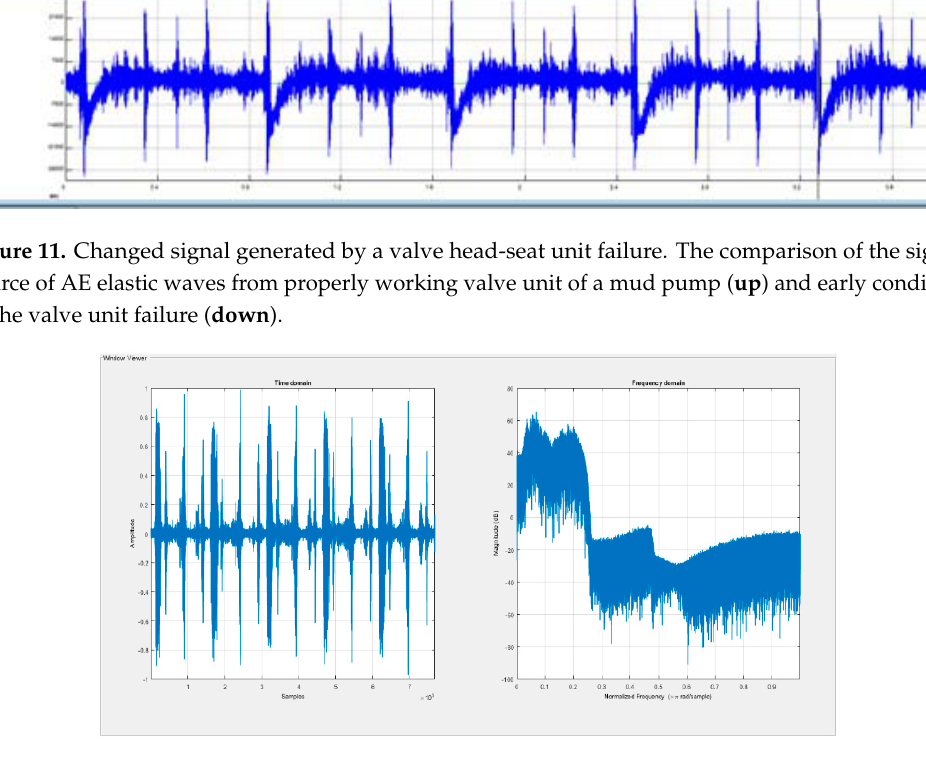
Figure 12. Analysis of the signal from the correctly working mud pump valve. The amplitude-time signal ( left ) and magnitude (dB) as a function of frequency ( right ).